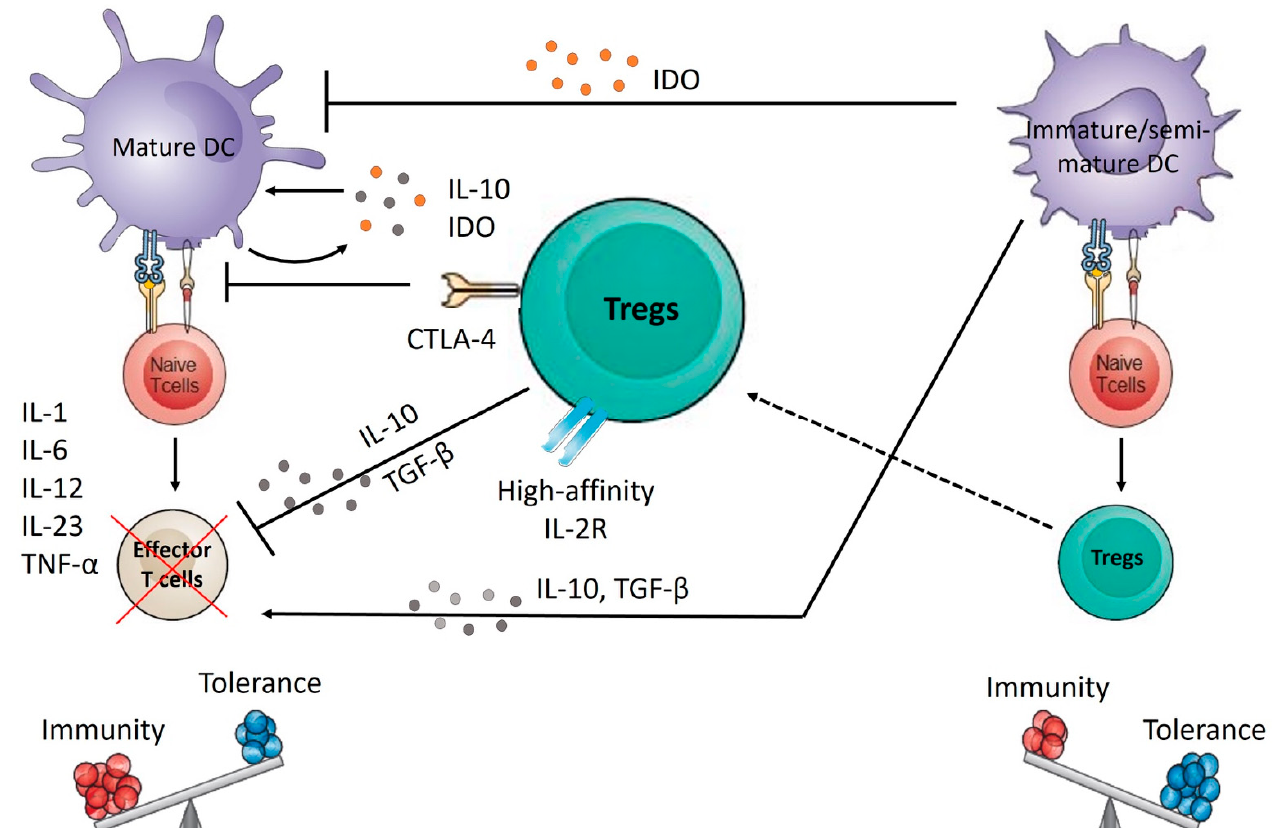
Figure 4. Schematic representation of dendritic cells and regulatory T cell interactions. Imma- ture/semimature DCs secrete IDO impeding DC maturation as well as anti-inflammatory cytokines, such as IL-10 and TGF- β , inhibiting effector T cell activation. Immature/semimature DCs also give rise to Tregs, which contribute to immune tolerance by blocking the priming of effector T cells directly via IL-10 and TGF- β or indirectly through interactions with DCs and by blocking their maturation with the help of CTLA-4. CTLA-4 expressed on Treg has a higher affinity for CD80/86 molecules expressed on DCs than CD28 molecules expressed on effector T cells, meaning that Tregs competes with the effector T cells to bind CD80/CD86. DC CD80/CD86 and Treg-CTLA-4 interaction also results in the secretion of IL-10 and IDO, which contributes to the restraint of DC maturation. Treg can also preferentially sequester the T-cell proliferation factor IL-2 due to the high expression of constitutive IL-2R (CD25). The dotted line is used to emphasize that some differentiated Tregs use the above mechanisms to suppress effector T cells activation and balance immunity and tolerance. Tregs, regulatory T cells; IL-10, interleukin-10; TGF- β , tumor growth factor-beta; IDO, Indoleamine